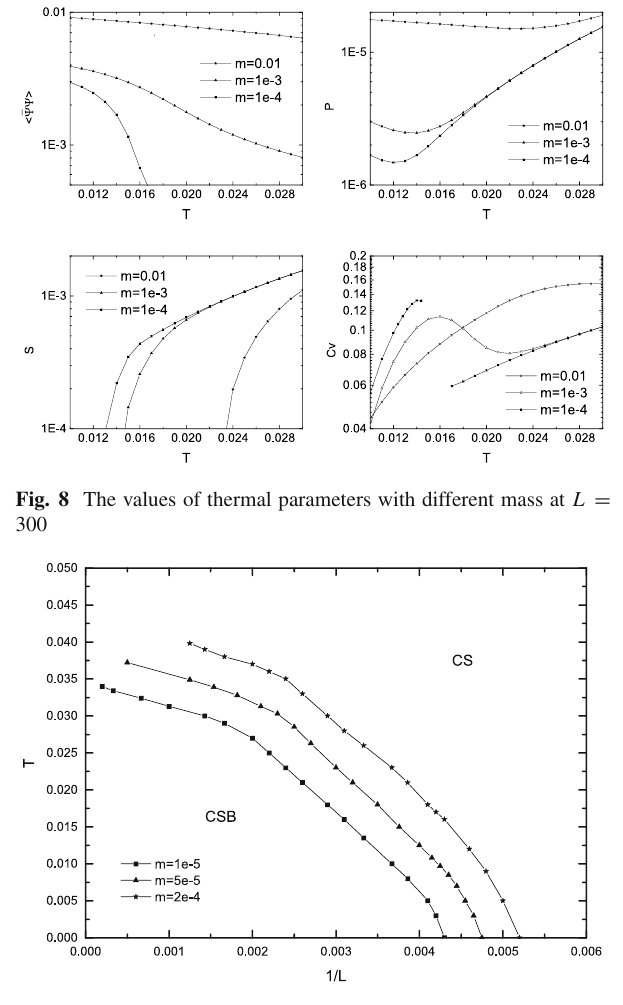
Fig. 9 The phase diagram of thermal QED 3 with several fermion mass (Thesolidlinerepresentsthephaseboundary,andtheundrawnpartnear the temperature axis illustrates a crossover)